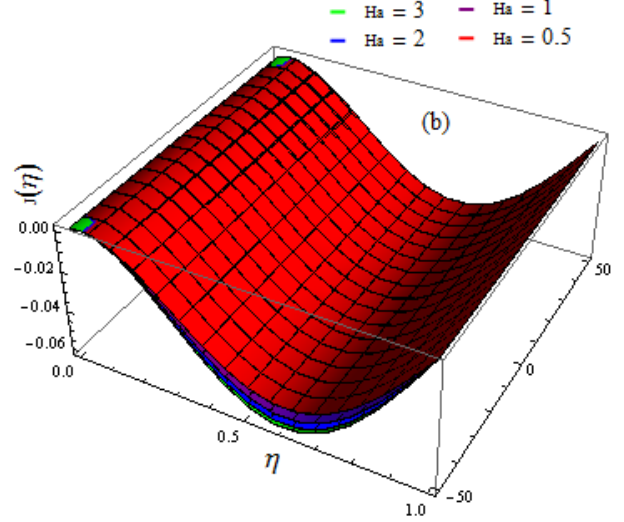
Figure 7. ( a ). Influence of 𝐻𝑎 on 𝑓 ′ (𝜂) . ( b ) Influence of 𝐻𝑎 on 𝐽(𝜂) .